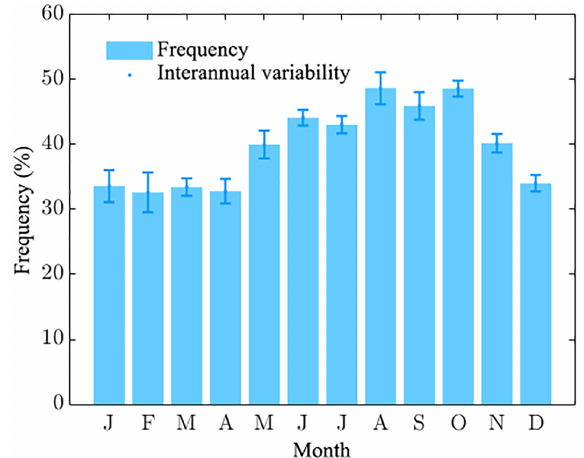
Figure 7. Annual cycle of blowing snow frequency at Neumayer III station, derived by the BSD algorithm (blue bars) for the period 2011–2015. The error bars represents the interannual